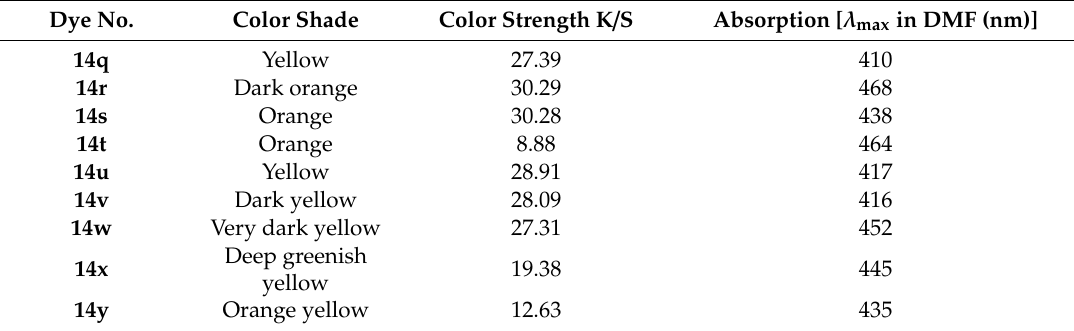
Table 1. Optical measurements of polyester